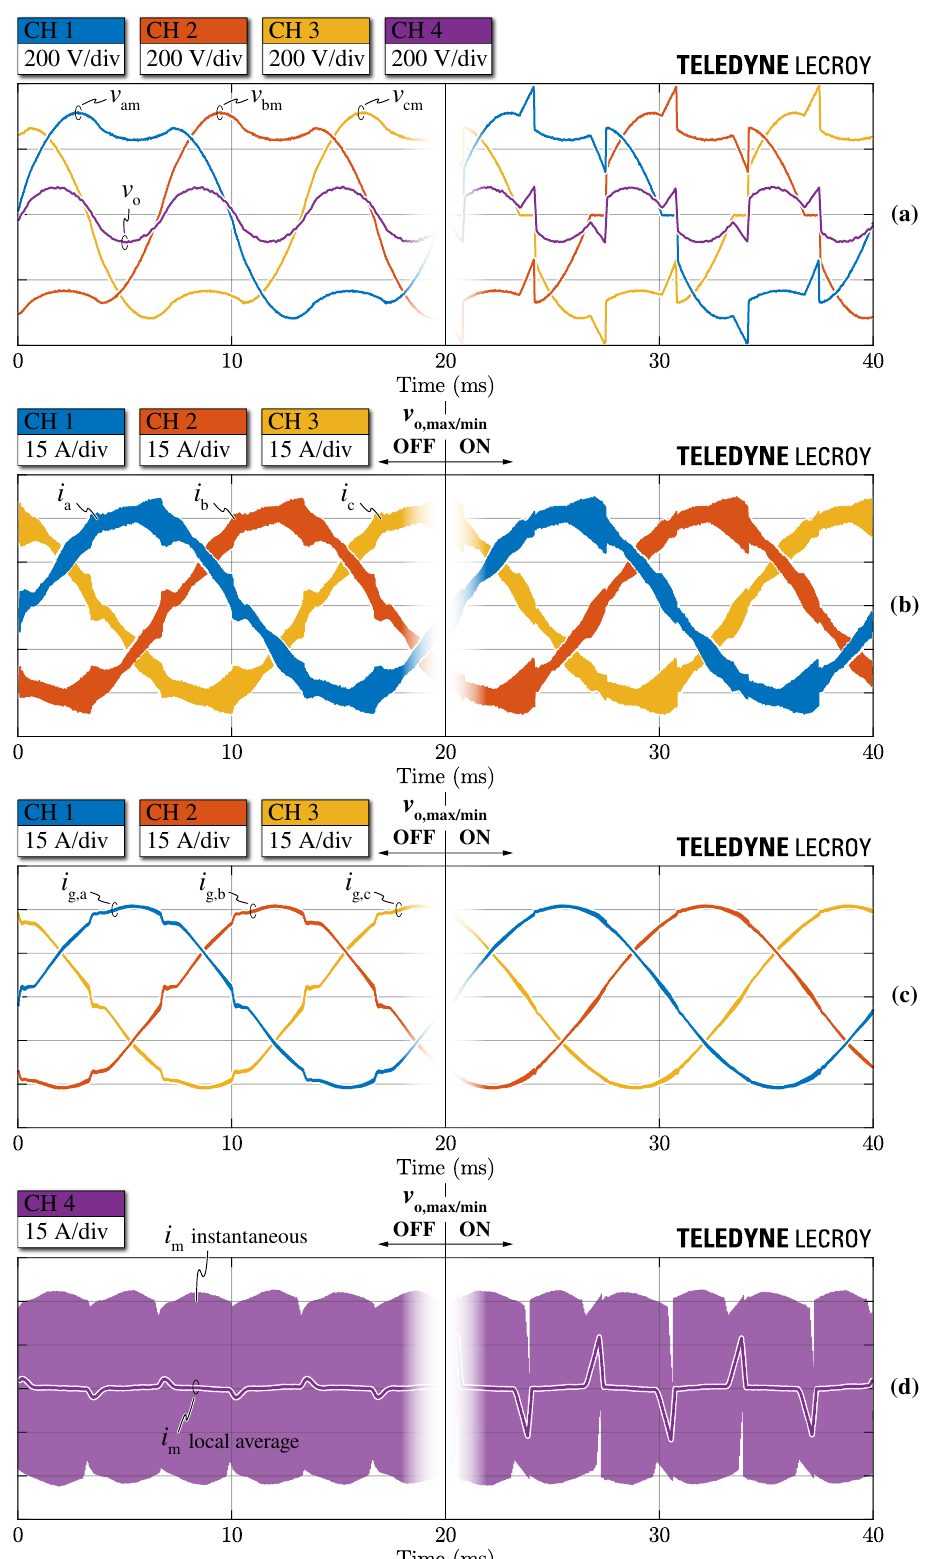
Figure 17. Experimental waveforms in steady-state conditions with V dc = 800V, ϕ = 15° and S = 15kVA. From top to bottom: ( a ) reference bridge-leg voltages v am , v bm , v cm and zero-sequence voltage v o (from DAC of the MCU), ( b ) converter-side currents i abc , ( c ) grid-side currents i g,abc , ( d ) and mid-point current i m , with and without the zero-sequence voltage saturation v o,max/min